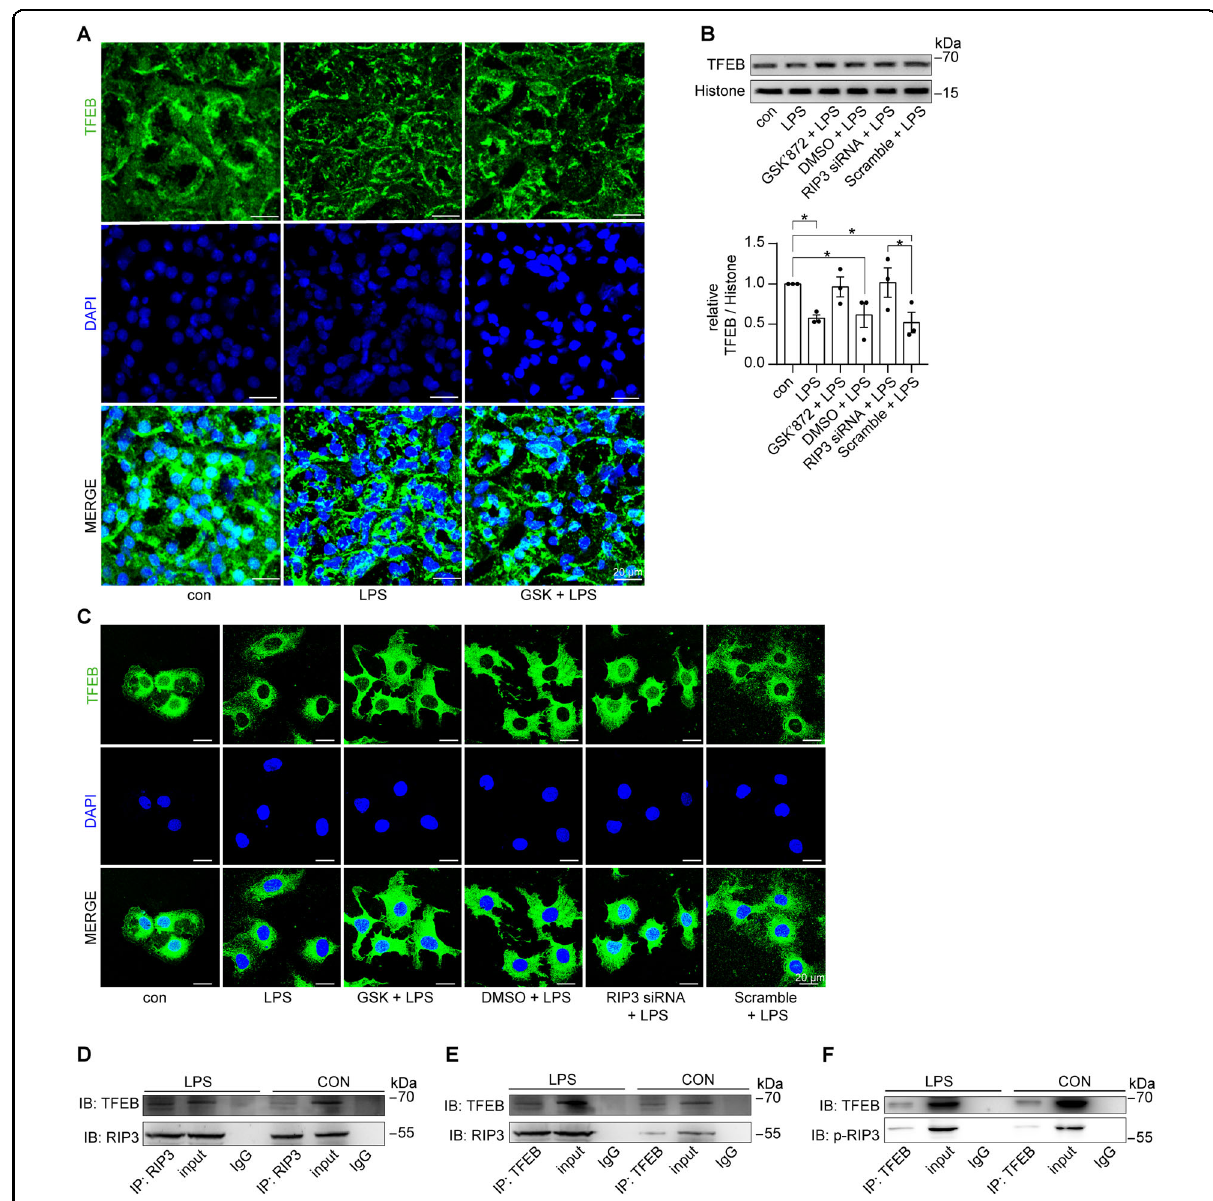
Fig. 5 RIP3 impeded the nuclear translocation of TFEB in septic AKI mice and LPS-treated cultured PTECs. A Immuno fl uorescence staining for TFEB (green) and DAPI (blue) in the kidneys from C57BL/6 mice treated with sterilized saline (con), LPS, or LPS plus GSK ’ 872 (GSK) for 24 h. GSK partially restored the decreased nuclear staining of TFEB in the renal tubular cells of LPS-induced mice. Scale bar = 20 μ m. B Cultured PTECs treated with LPS, LPS plus GSK, LPS plus DMSO, LPS plus RIP3 siRNA, or LPS plus scrambled siRNA (Scramble) for 12 h. The nuclear protein fractions were immunoblotted for TFEB. Histone was used as the nuclear marker. TFEB expression against Histone was decreased by LPS treatment, which was restored by GSK or RIP3 siRNA ( n = 3). C Immuno fl uorescence staining for TFEB (green) and DAPI (blue) in cultured PTECs treated as indicated. The nuclear translocation of TFEB was inhibited by LPS, which was rescued by GSK or RIP3 siRNA. Scale bar = 20 μ m. D , E Lysates from cultured PTECs treated with LPS or DMSO (con) for 12 h were subjected to immunoprecipitation using an anti-RIP3 antibody ( D ) or anti-TFEB antibody ( E ), and IgG antibody followed by immunoblot for TFEB and RIP3. Input proteins were detected with anti-RIP3 and anti-TFEB antibodies. RIP3 interacted with TFEB in LPS-treated PTECs compared to the control group. F Lysates from cultured PTECs treated with LPS or DMSO (con) for 12 h were subjected to immunoprecipitation using anti-TFEB antibody and IgG antibody followed by immunoblot for p-RIP3. Input proteins were detected with anti-p-RIP3 and anti-TFEB antibodies. p-RIP3 interacted with TFEB in LPS-treated PTECs compared to the control group. * P <